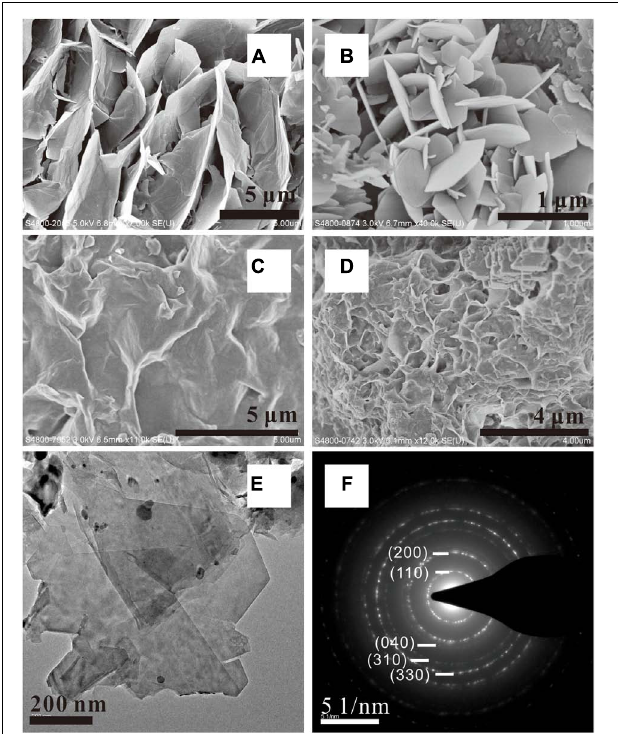
FIGURE 3 | SEM (A–D) and TEM (E) observations of Mg–Al–Fe smectite formed in [H 2 O-CO 2 ]-komatiite system. The SAED pattern (F) shows clear diffraction rings indicating disordered stacking of individual